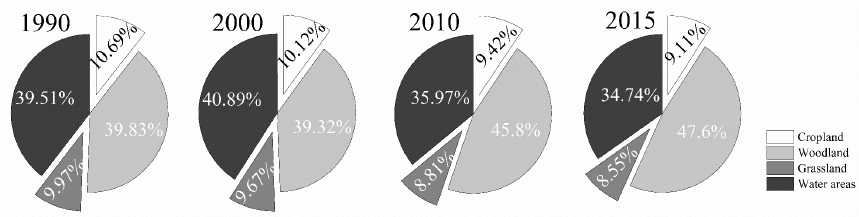
Figure 3. Contributions of ecosystem service values of each land use type to the total in the Jing-Jin-Ji region.